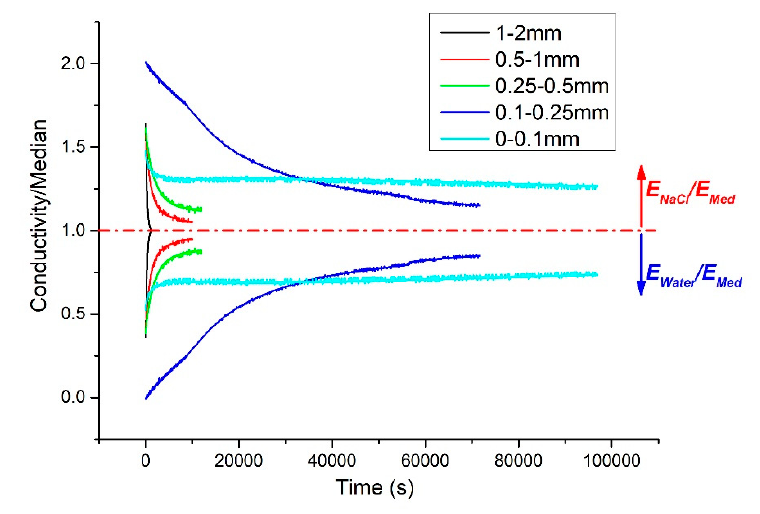
Figure 13. Concentration variation curves during molecular diffusion in coral sands.